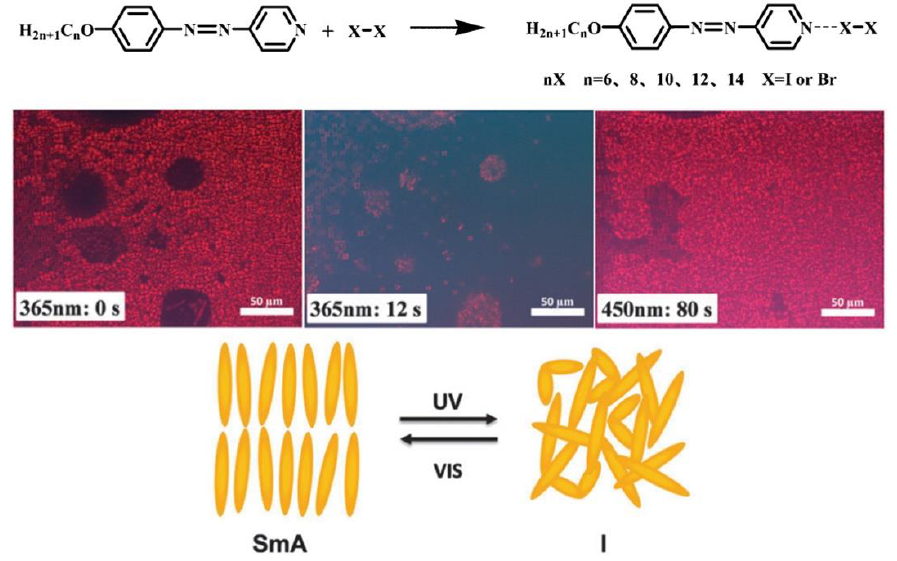
Figure 15. Possible molecular scheme of halogen complexes of AnAzPy and POM observation of 12I at its LC phase upon UV irradiation. The right picture was obtained after irradiation with visible light for 80 s. Reprinted with permission from [89]. Copyright 2014, Royal Society of Chemistry.